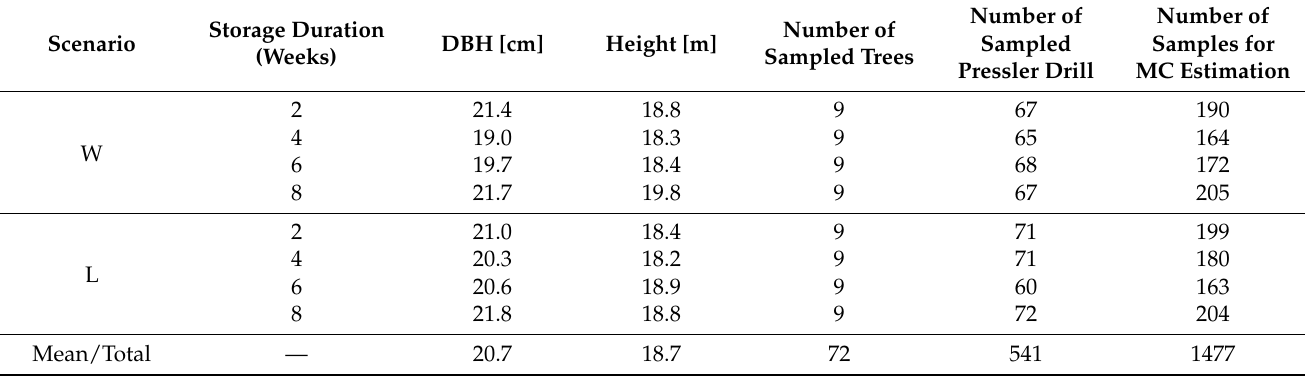
Table 1. Characteristics of model trees and summary with total number of samples for the